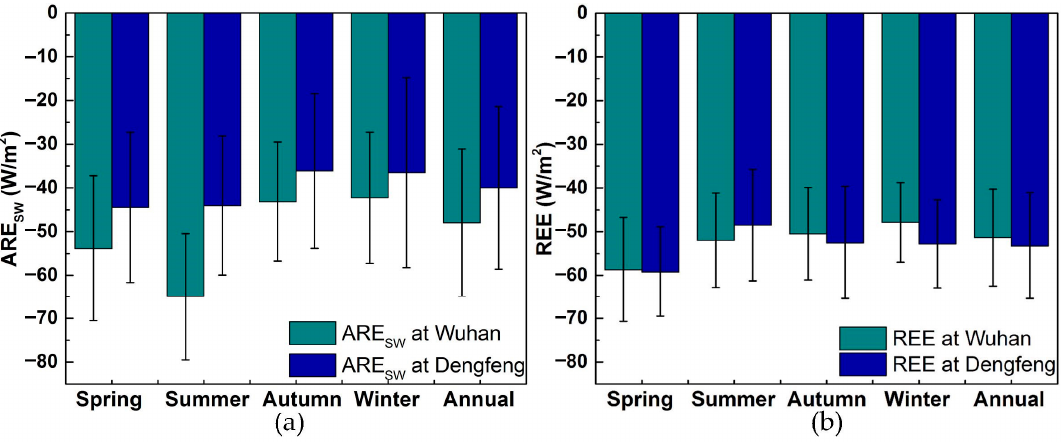
Figure 12. Annual and seasonal average ( a ) ARE SW and ( b ) REE in Wuhan and Dengfeng.